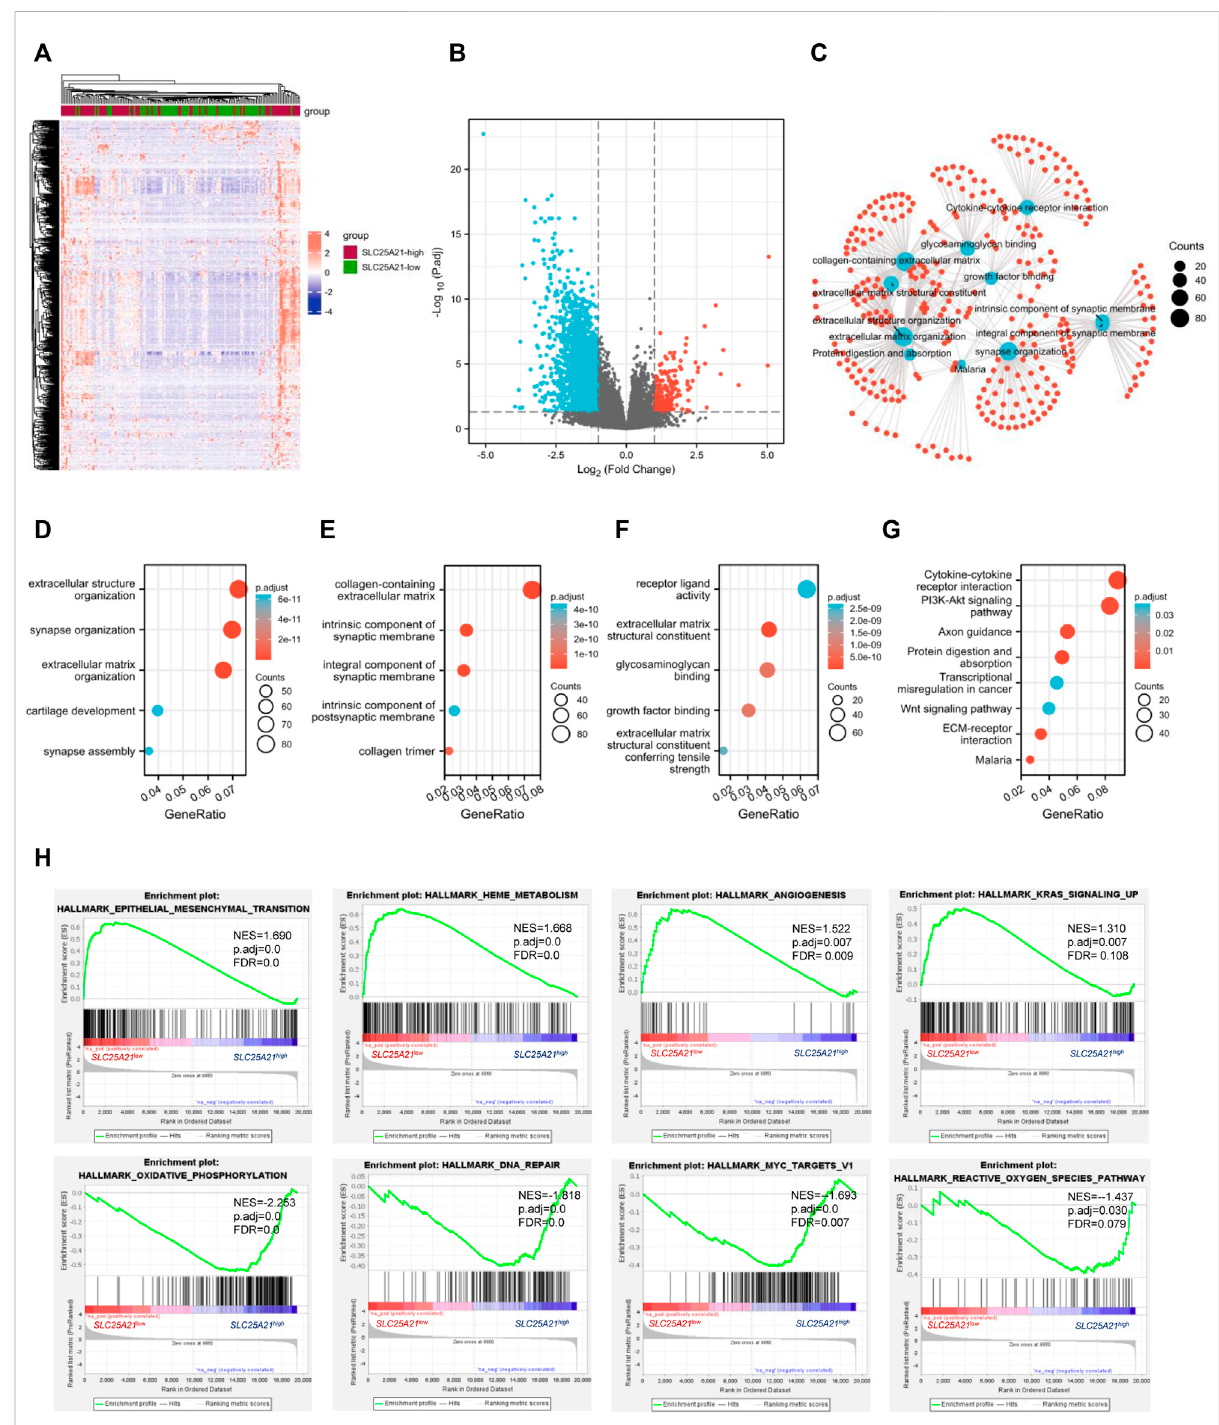
FIGURE 4 DEGs and functional enrichment of the high- and low- SLC25A21 expression groups in AML. (A) Heatmap of SLC25A21-related DEGs. (B) VolcanoplotofSLC25A21-relatedDEGs. (B,C) InteractiveanalysesofGOandKEGG,includingbiologicalprocesses (D) ,cellularcomponents (E) ,and molecular functions (F) , and KEGG pathways of SLC25A21-related DEGs. (G) Each red plot in the graph represents a speci fi c gene included in the gene-set. Each blue plot represents the enriched gene-sets. The size of the blue plot represents the number of gene read counts in the gene- sets. (H) GSEA of SLC25A21-related